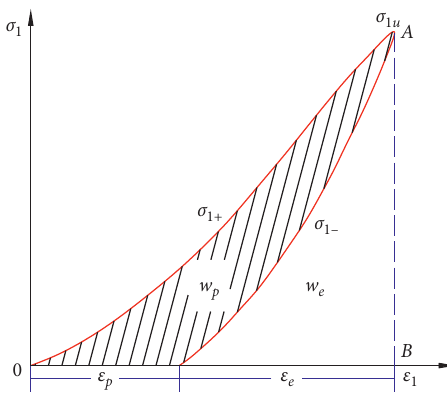
Figure 1: Conventional calculation of strain energy.